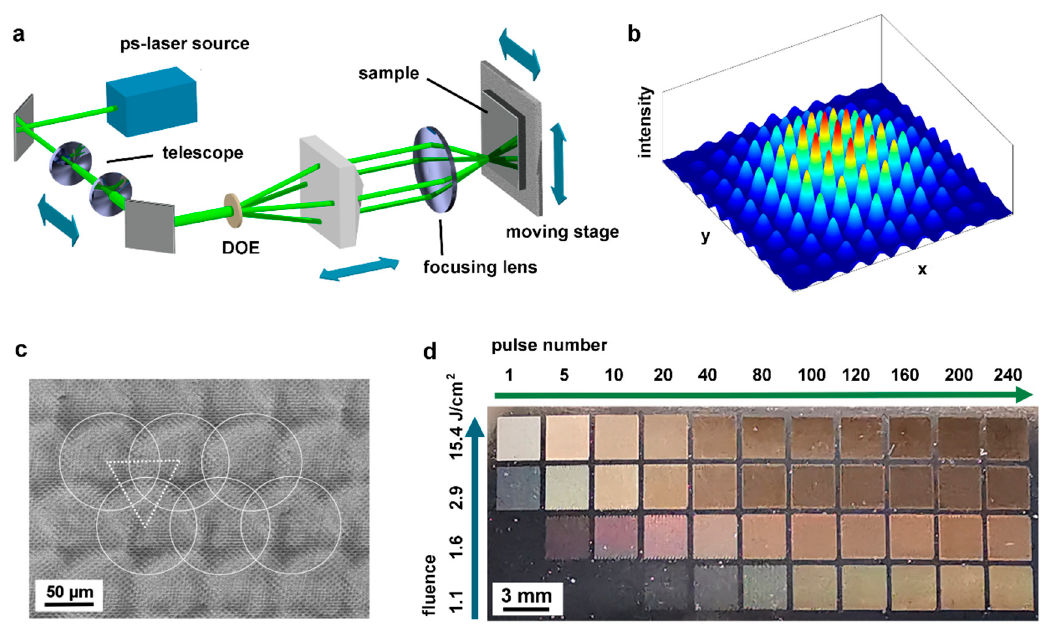
Figure 1. ( a ) Schematic of the DLIP experimental setup. ( b ) Intensity distribution of four symmetrically-distributed beams’ interference. ( c ) SEM image of microstructures fabricated by DLIP on Cr (fluence: 1.6 J / cm 2 , 10 pulses). White circles indicate the laser interference spots irradiated on the Cr surface, which are approximately 102 µ m in diameter and arranged in a triangular pattern (white dot line) with an overlap of 30%. ( d ) Photograph of a four-beam laser processed Cr sheet. The laser fluence was increased from 1.1 J / cm 2 to 15.4 J / cm 2 (from the bottom to the top) and the pulse number was raised from 1 to 240 (from left to right).